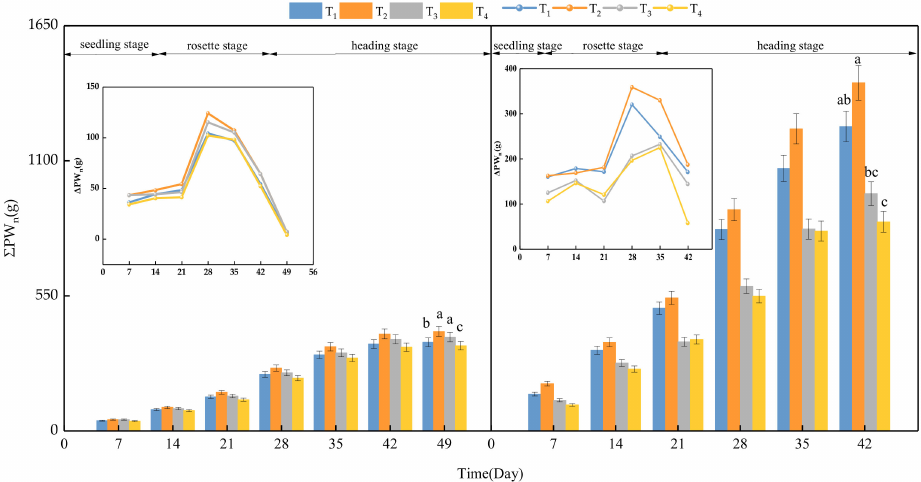
Figure 7. Changes of lettuce weight under different water treatments. Note: The bars with different letters showed significant difference ( α = 0.05). The same as below.